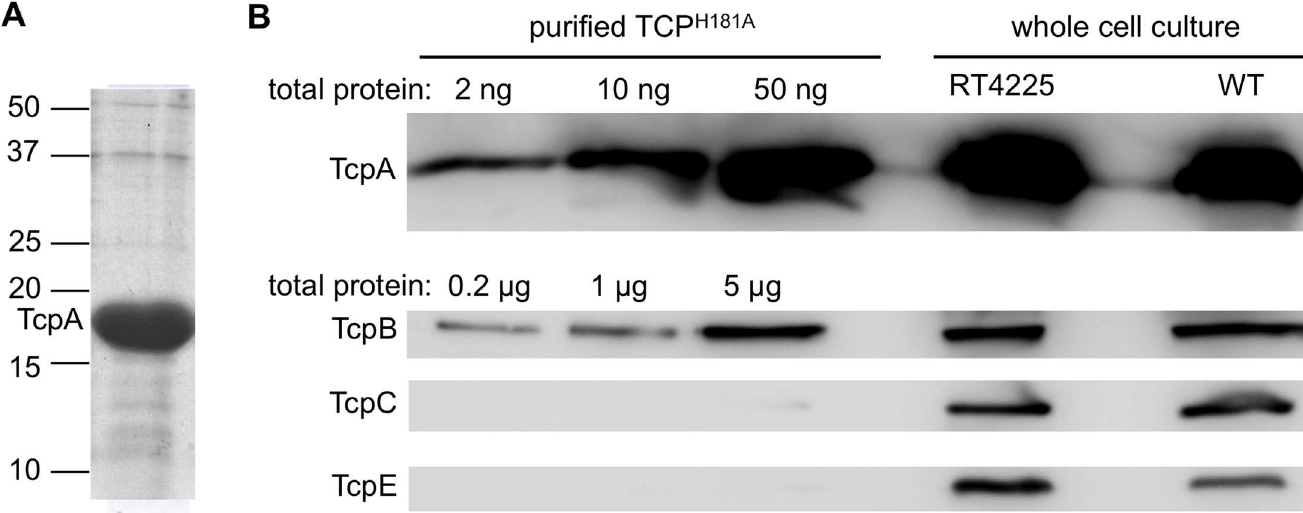
Fig 4. Co-localization of TcpB with purified TCP H181A . (A) Coomassie-stained SDS gel of TCP H181A purifiedfrom V . cholerae RT4225, which has a mutation encoding a His181Alasubstitutionin the major pilin, TcpA. The protein concentration of the solution was found by spectrophotometry (A 280 ) to be 10 mg/ml. The lane was overloadedwith 90 μ g of protein to show the purity, estimated at > 95%. The positionsof mass markers are indicated.The protein band at ~50 kDa is not likely to be TcpB (46 kDa), which based on the TcpA:TcpB stoichiometry determination(see below) is present in quantitiestoo small to detect by Coomassie stain. (B) Immunoblotsof pilins and pilus assembly componentsin purifiedTCP H181A and wholecell culture. For the purified TCP H181A samples, the total amount of protein loadedis indicated; for the wholecell culture samples, 25 μ l was loadedinto each well. Blots were probed with antibodiesagainst TcpA and TcpB; TcpC and TcpE were also probedto assess contamination from outer and inner membranes, respectively. All blots were developed for 2 minutes.